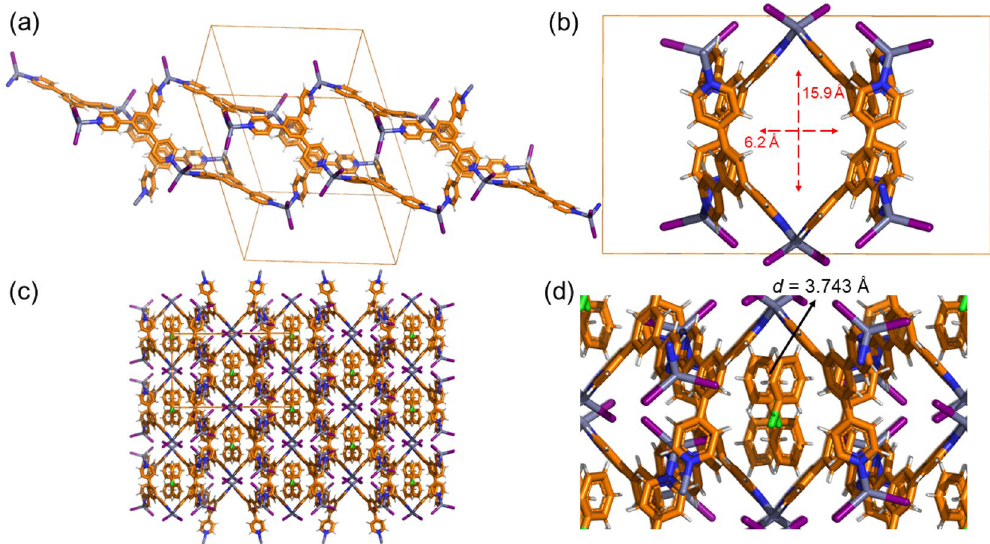
Figure 7. Single crystal X-ray structure of 2 depicting ( a ) the propagation of the tubular structure formed by the circuits; ( b ) view of the tube structure along the c -axis; ( c ) the packing of the tubular structures viewed along the c -axis including the guest molecules; and ( d ) expanded view of the 1D channel structure (tubular) including the solvent dichlorobenzene